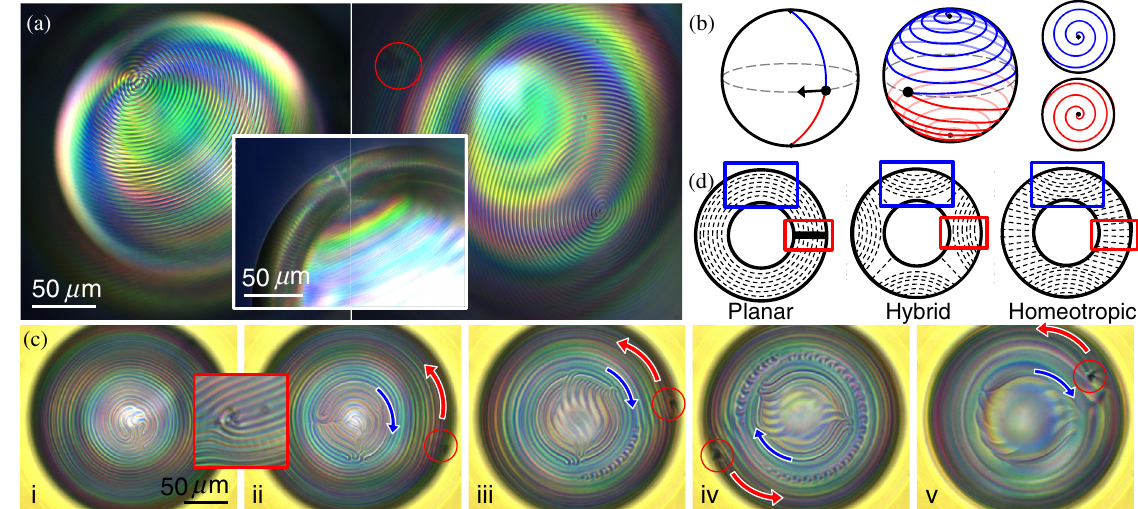
FIG. 7. Equilibrium thin stripes. (a) A CLC shell with 7-mM SDS in the water phases equilibrates after one month, leaving only two, topologically required FCDs. The inset shows a side view of a FCD. (b) Schematic showing how two spirals can form on a sphere from a line connecting the two poles. For two spirals of opposite handedness, a point (black) must exist where the handedness is not defined, playing the role of the stripe dislocation in the right of (a) and in the red inset of (c). (c) Two FCDs in an equilibrated CLC shell, having double spirals of the opposite handedness and requiring a stripe dislocation (red inset). When the surfactant is washed away, the stripes rotate as they become wider and unwind, which is evident from the opposite rotation of FCD poles (blue arrows) with respect to the stripe dislocation (red arrows). The stripes widen first at the poles [(i) and (ii)] until an instability occurs [(iii) and (iv)]. The stripe dislocation becomes the planar defect. (d) Schematic of cholesteric layers in a shell for planar, hybrid, and homeotropic anchoring. Blue boxes highlight the fact that layers do not rearrange much to accommodate the anchoring change near a FCD. The opposite is true away from a FCD, highlighted by red